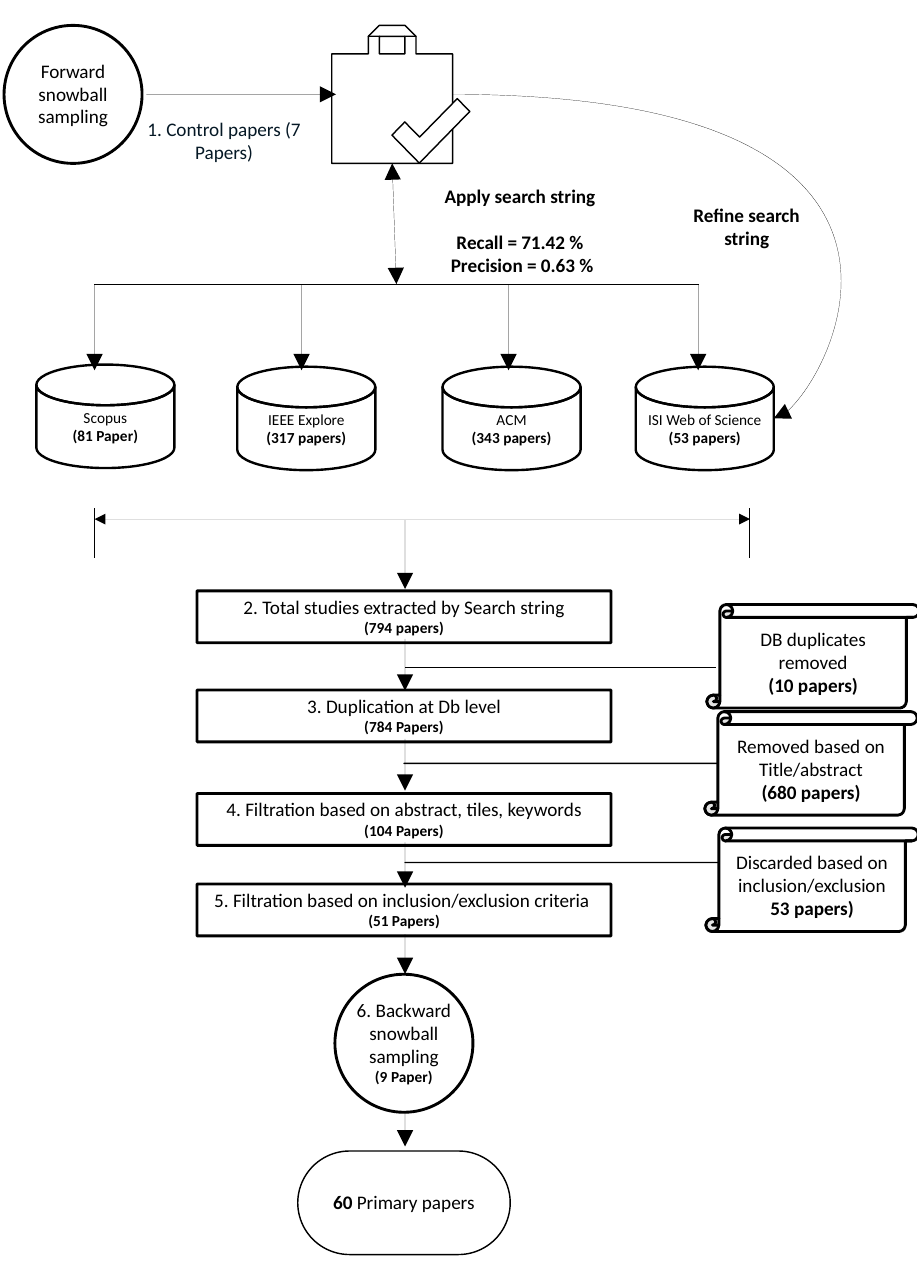
Figure 1. Systematic revision search